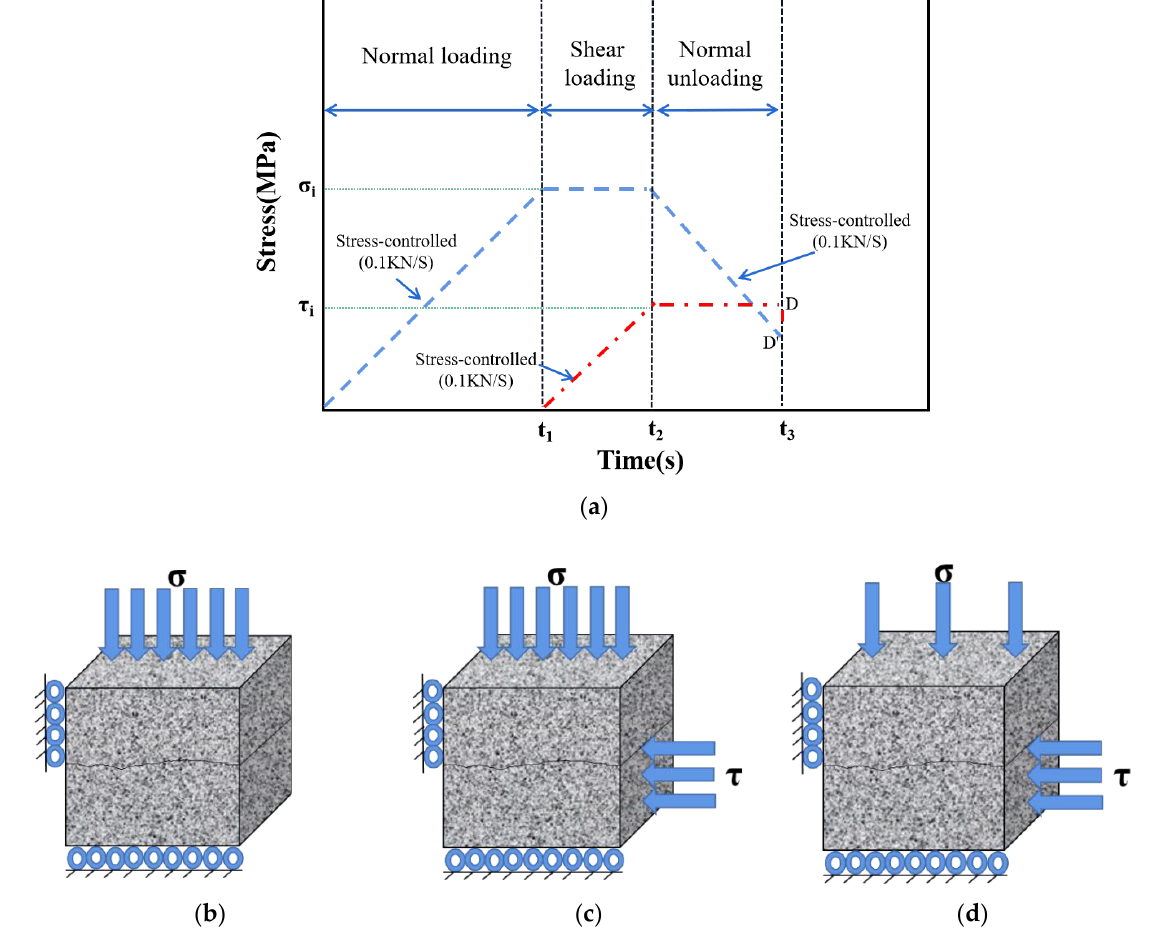
Figure 5. Stress path in the experimental process. ( a ) Loading process. ( b ) Step 1. ( c ) Step 2. ( d ) Step 3. Step 3: the initial shear stress τ i is kept constant, and the normal stress is unloaded method adopted in the test, when the specimen fails, the curve drops sharply (D and D (cid:48) in Figure 5a).